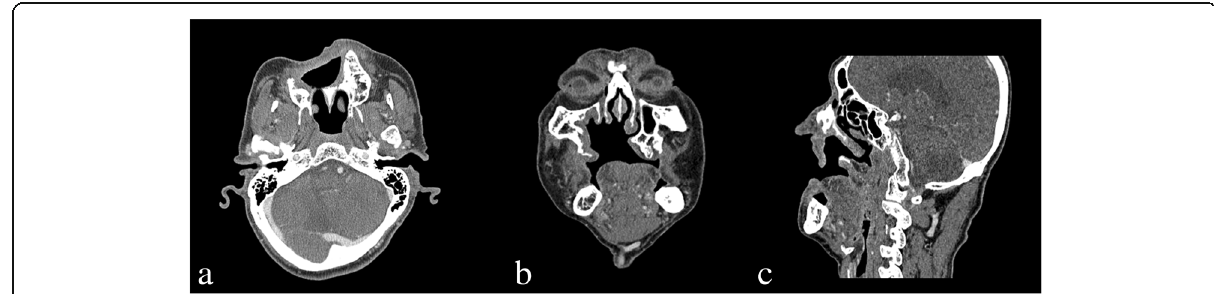
Fig. 7 Facial CT image acquired 1 year after surgery indicates no recurrence of findings. a Axial view. b Coronal view. c Sagittal